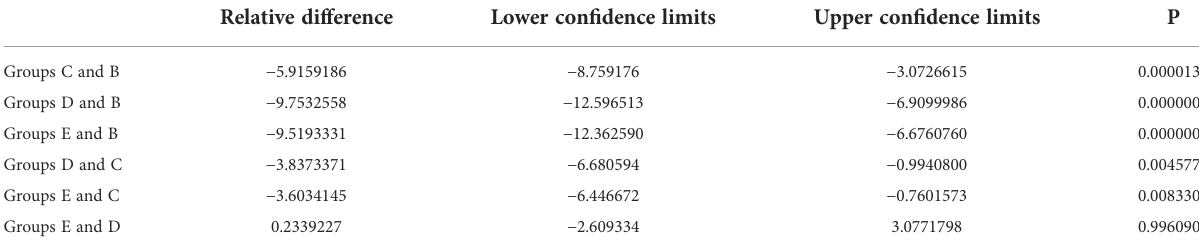
TABLE 12 Results of pairwise comparison of IL-17A.